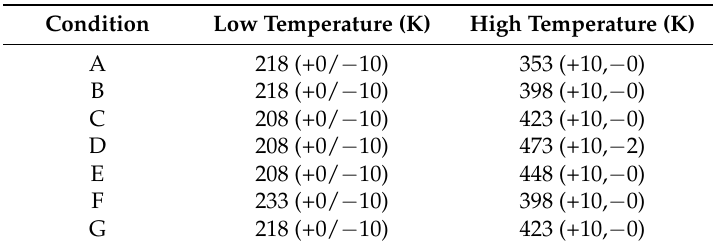
Table 3. The heat shock test standards.